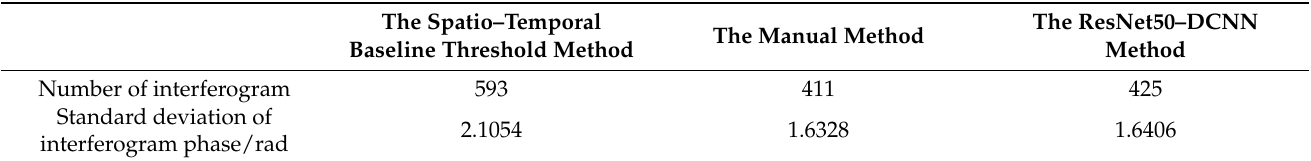
Table 3. Derived number and standard deviations of the interferogram phase obtained by the three methods.